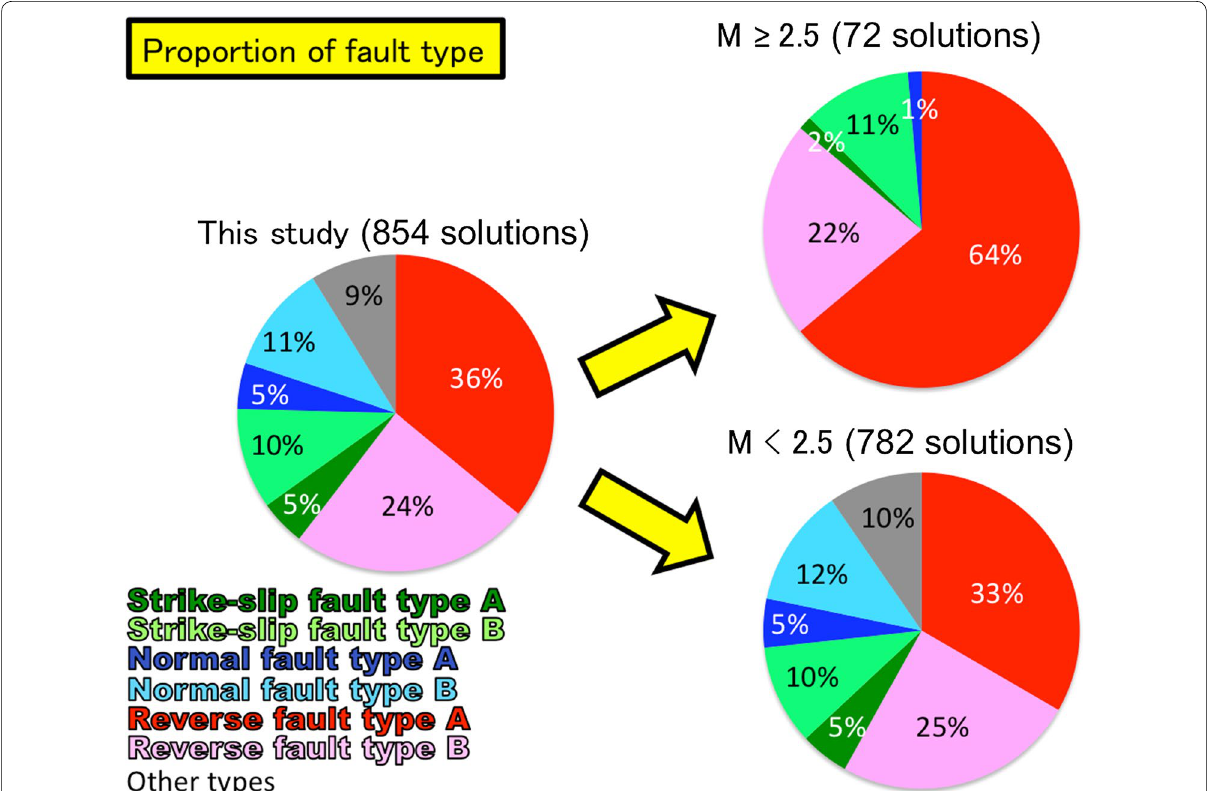
Fig. 6 Pie charts showing the proportion of each fault type. The distributions of events with M Fig. 3 and text for the explanation of grades A and